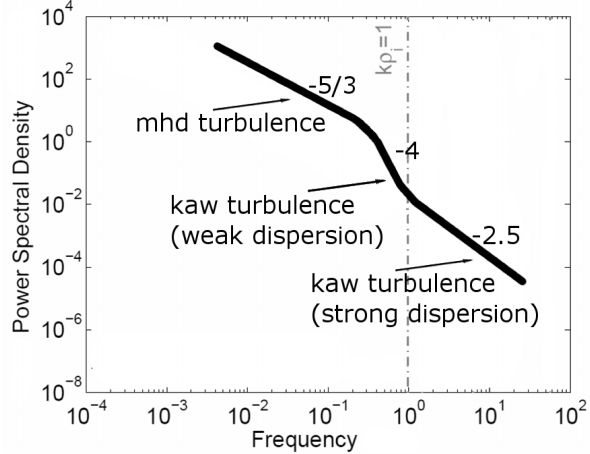
Fig. 1. Turbulent Alfv´enic spectrum extending over three ranges, with the steepest slope in the weakly/mildly dispersive KAW range (interpretation of the spectrum shown in Fig. 1 by Chen et al., 2010).